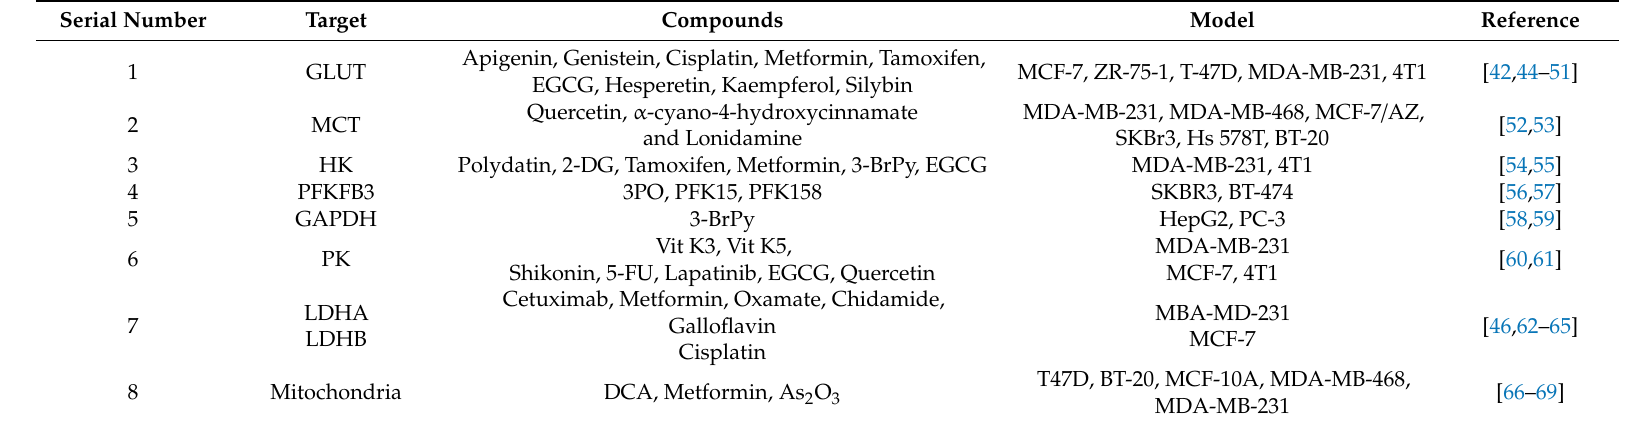
Table 1. A list of glycolytic inhibitors targeting critical enzymes in the glucose metabolic